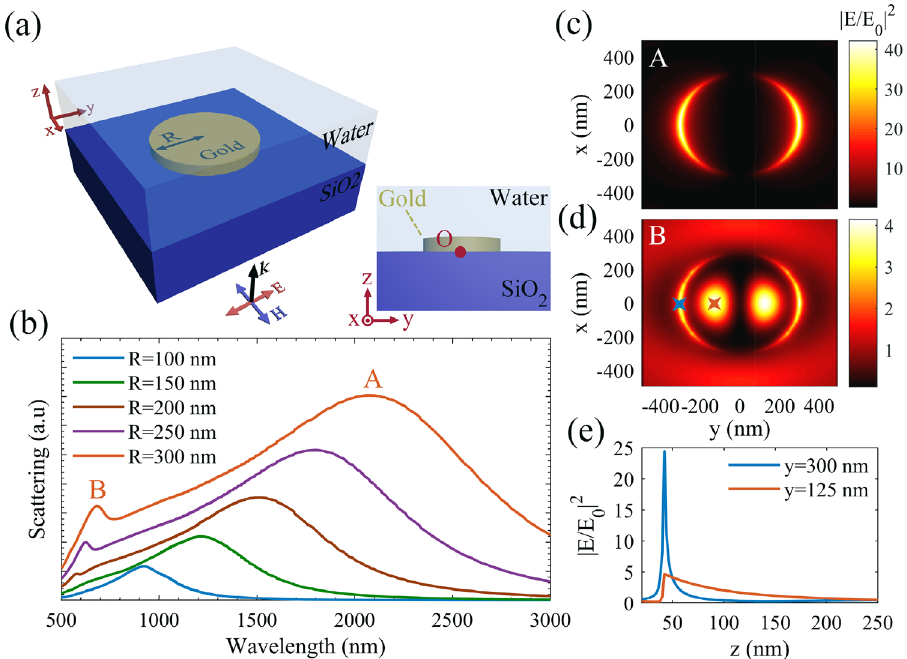
Figure 2. ( a ) Scheme of a single gold nano-disc, which is shown illuminated by a y -polarized input source. ( b ) The calculated scattering spectra of the nano-disc with R = 100, 150 nm, 200 nm, 250 nm, and 300 nm. The top view normalized field intensity distributions at z = 50 nm for ( c ) λ 0 = 2080 nm (marked by A), and ( d ) λ 0 = 680 nm (marked by B). ( e ) The normalized plasmonic field intensity along the normal directions at x = 300 nm, y = 0 (marked by the blue cross in part ( d )), and at x = 125 nm, y = 0 (marked by the red cross in part ( d